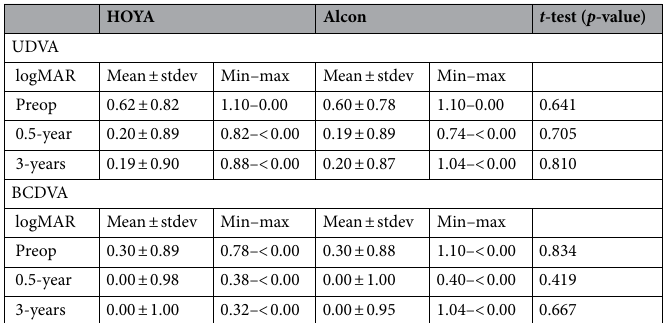
Table 4. Glistening scores—frequency/proportion per visit. IOL intraocular lens.